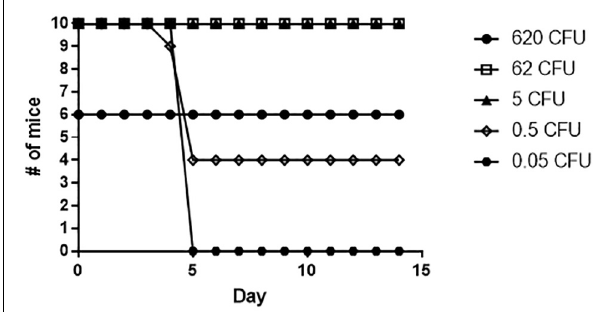
FIGURE 9 | Fn slt provides protection against challenge with Fn WT. Mice surviving the initial Fn slt exposure ( n = 10, and n = 6 for the 620 CFU group) were challenged after 28 days with 35 CFU of the Fn parent